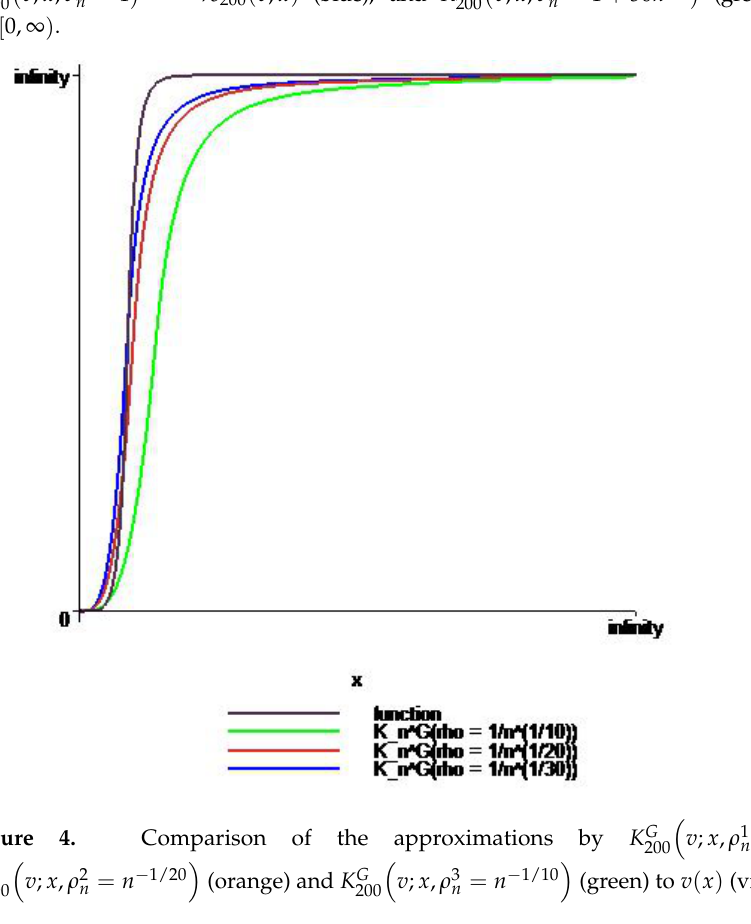
(cid:0) v ; x , σ 1 n = 1 − 50 n − 1 200 (cid:0) (cid:1) v ; x , σ 3 n = 1 + 50 n − 1 (green) to v ( x ) (violet) 200